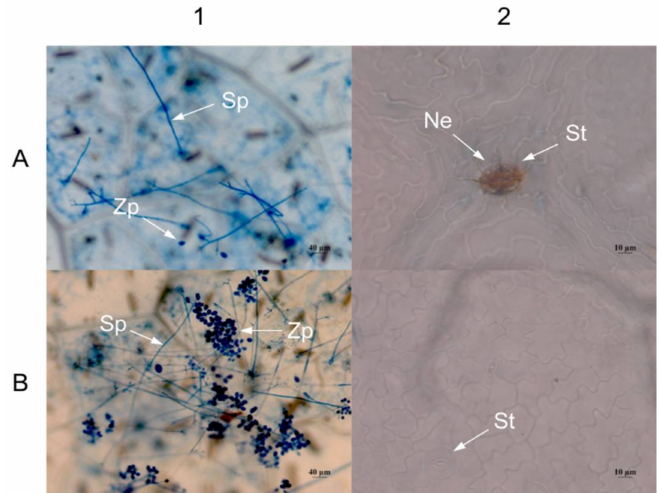
Figure 8. Microscopy examination of Vitis vinifera after infection with Plasmopara viticola . ( A ) V. vinifera expressing VaHAESA ; ( B ) V. vinifera transformed with the empty vector (pBI121). Representative images were taken 3 days after inoculation with Plasmopara viticola . Sp: Sporophore; Zp: Zoospore; St: Stomata; Ne: Necrosis.